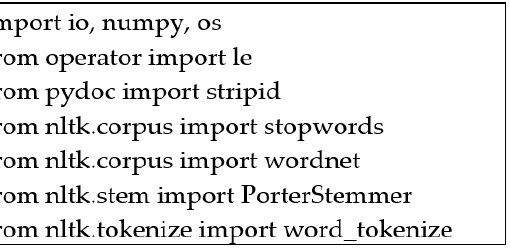
Figure 3. Algorithm of calculating synonyms between two classes. The algorithm in Figure 3 has been used for implementing Example 1 using the Py- thon programming language and the NLTK library.